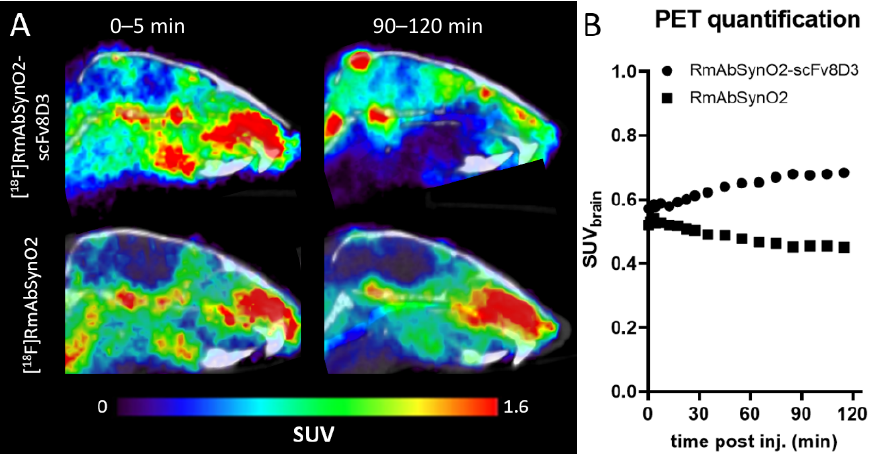
Figure 2. ( A ) Sagittal PET images of WT mice injected with [ 18 F]RmAbSynO2-scFv8D3 (upper; n = 1) or [ 18 F]RmAbSynO2 (lower; n = 1) at 0–5 min and 90–120 min post-injection. ( B ) Quantification of brain (whole brain except cerebellum) activity concentration (SUV) from 0–120 min after antibody injection in same animals as ( A ).